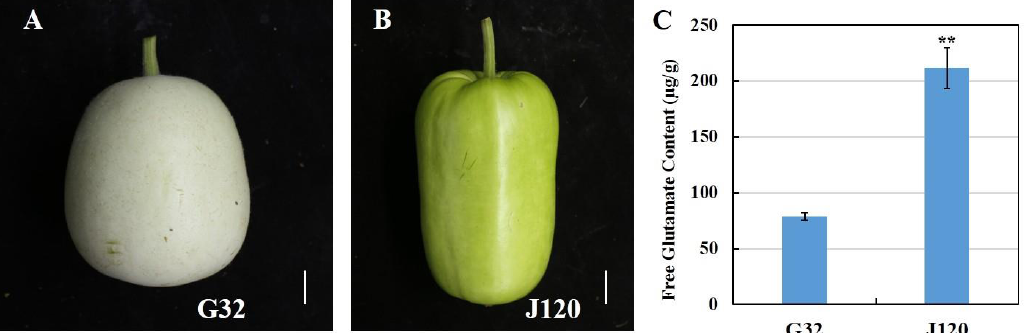
Figure 1. Marketable fruit from “G32” (weak flavor) and “J120” (strong flavor) collections and free glutamate contents. ( A ) Marketable fruit of “G32” , scale bar = 2.1 cm; ( B ) m arketable fruit of “J120” , glutamate contents. ( A ) Marketable fruit of “G32”, scale bar = 2.1 cm; ( B ) marketable fruit of “J120”, scale bar = 2.5 cm; ( C ) free glutamate con tent of “G32” and “J120” (** p < 0.01). scale bar = 2.5 cm; ( C ) free glutamate content of “G32” and “J120” (** p <